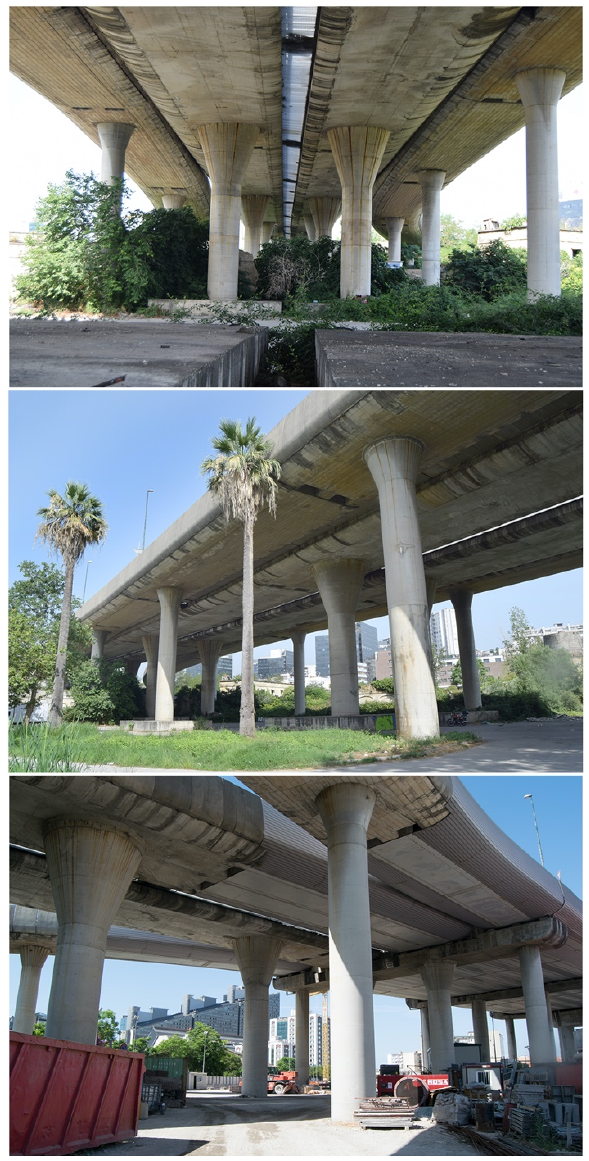
Figure 1. B-ROAD spaces in the East Side of